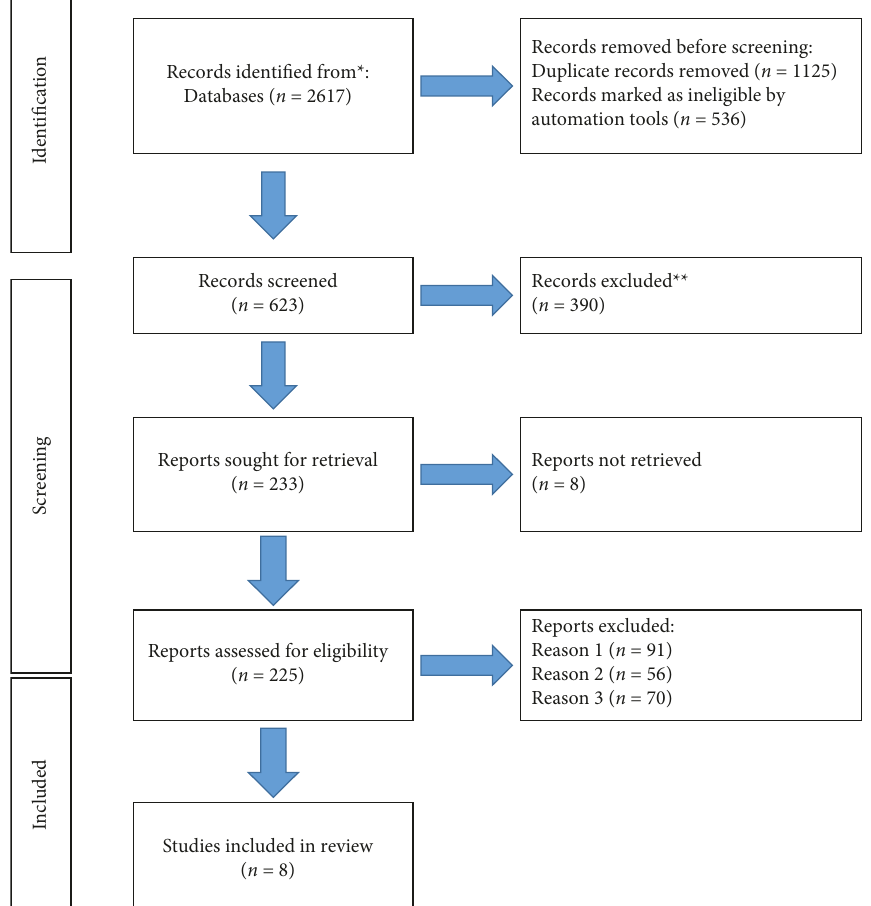
Figure 1: Illustration of literature